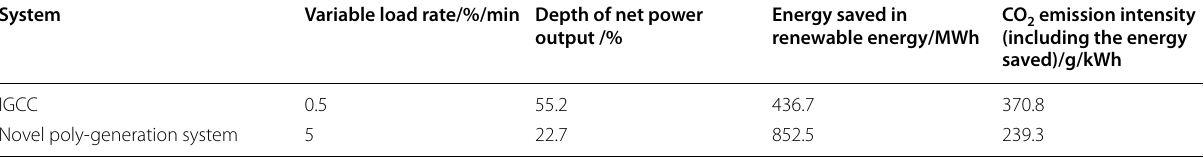
Table 7 Peak regulation performance comparison between the poly-generation system and the IGCC system